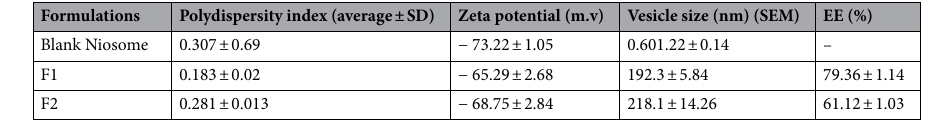
Table 3. Morphological features of Niosome-encapsulated imipenem compared to blank Niosomes.